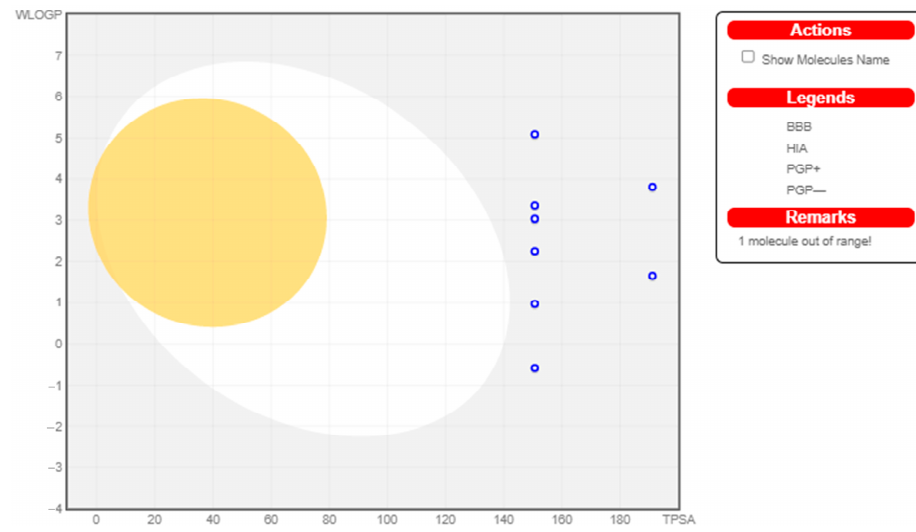
Figure 2. Swiss ADME Analysis of MCu1–MCu9. Table 3. Swiss ADME of MZn1–MZn9.